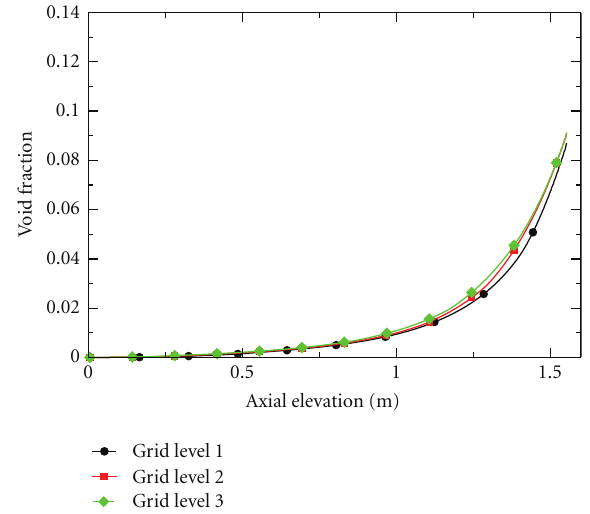
Figure 11: Yao-Morel model: Grid influence on the void-fraction axial evolution for run 1.2211.